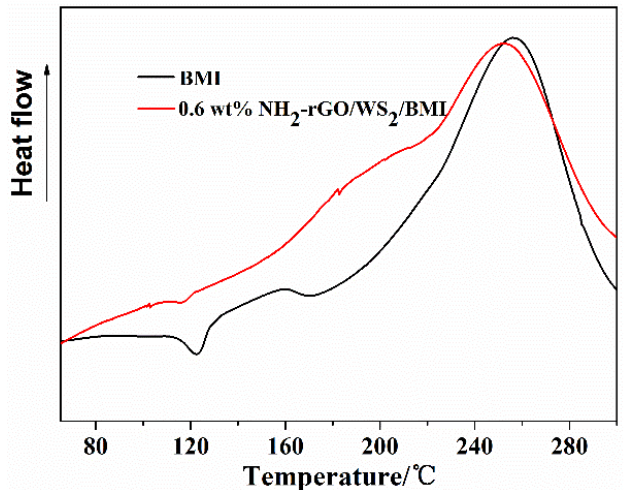
Figure 7. DSC curves of the neat BMI resin and 0.6 wt % NH 2 -rGO/WS 2 /BMI resin with a heating rate of 10 °C/min.